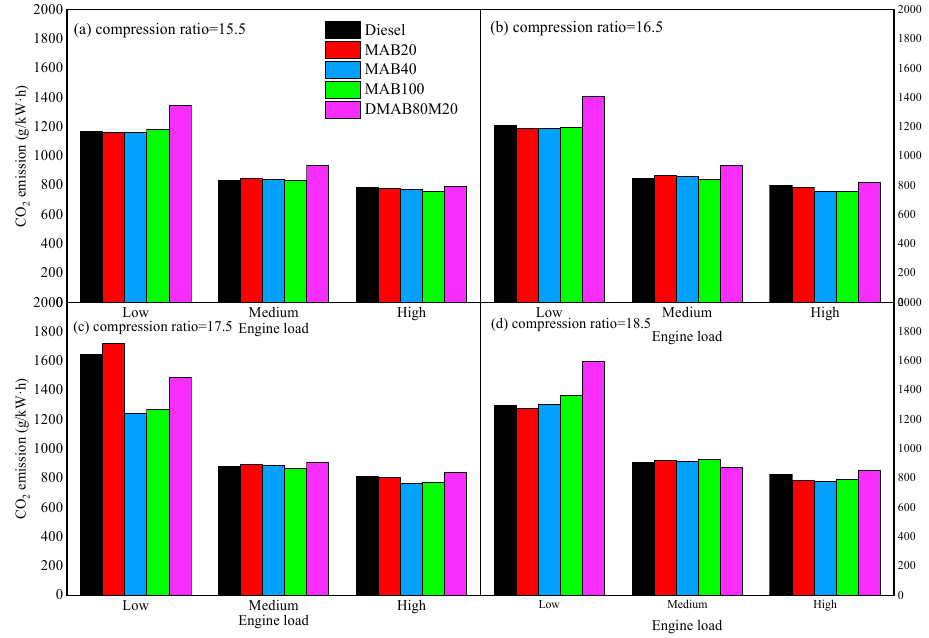
Figure 26. CO 2 emission comparison of biodiesel and diesel under different engine loads [231].